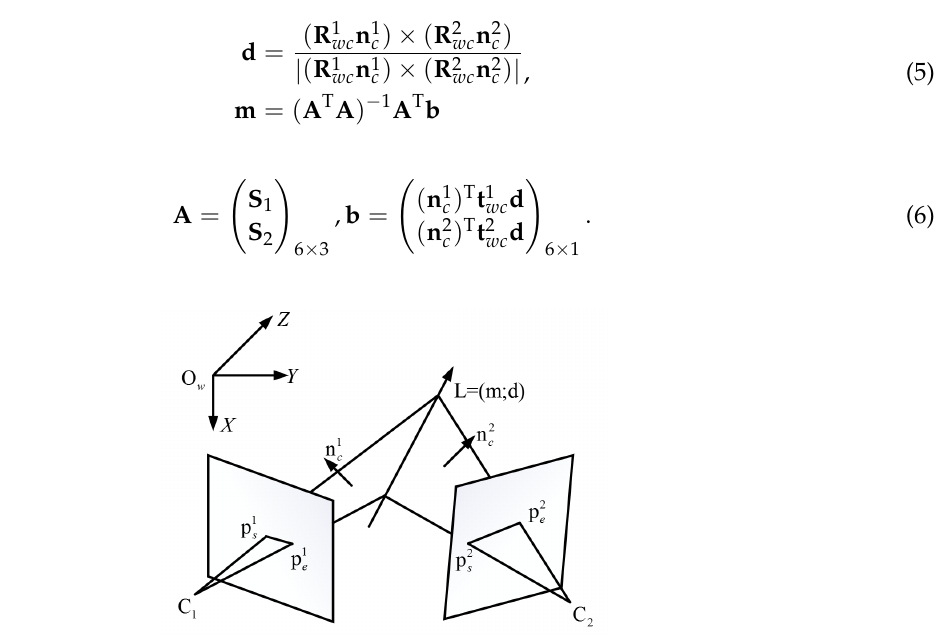
Figure 1. A 3D line is projected to two cameras. The line can be determined by intersecting two projection